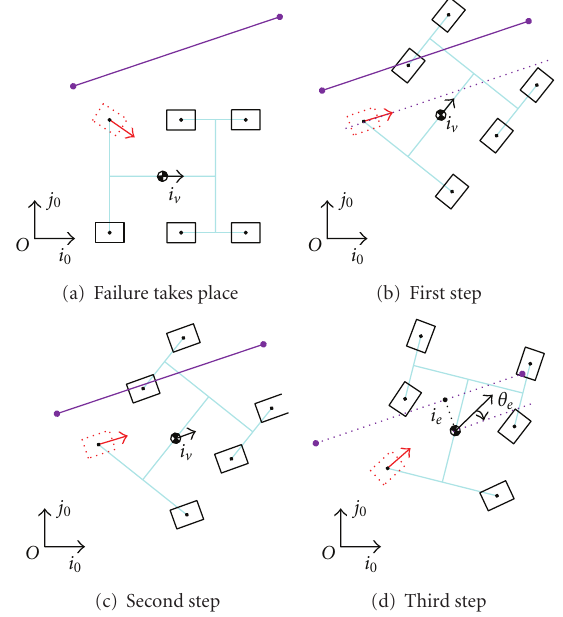
Figure 11: Three-step reconfiguration strategy in the case of F1.